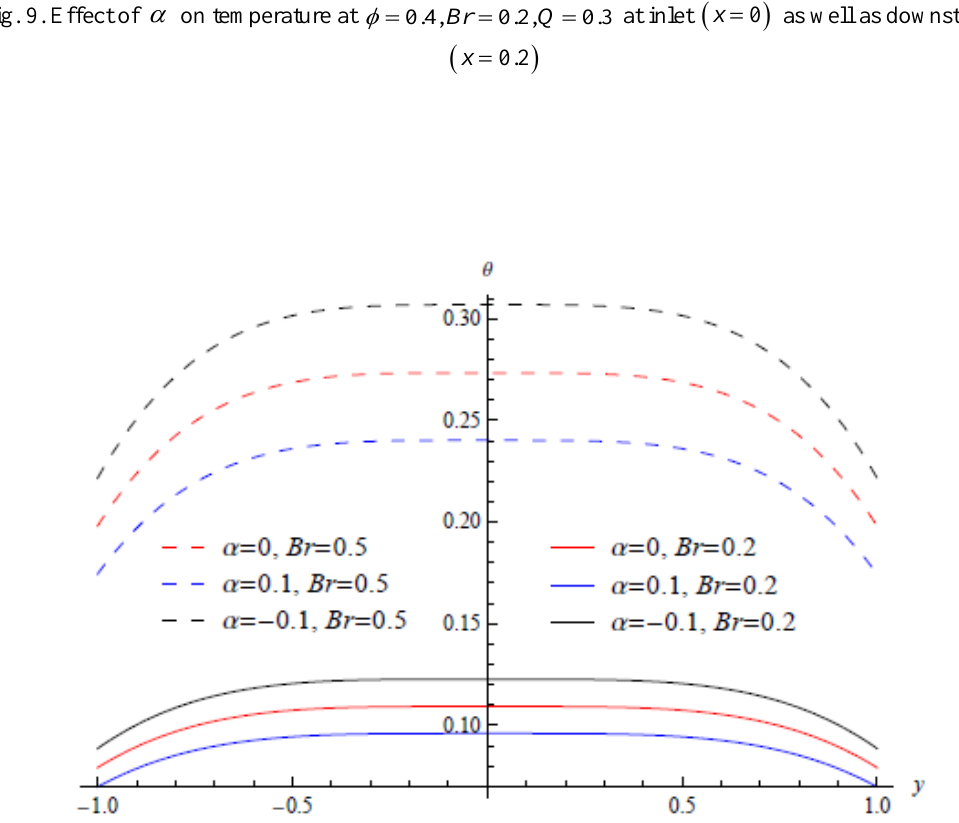
Fig. 9. Effect of  on temperature at